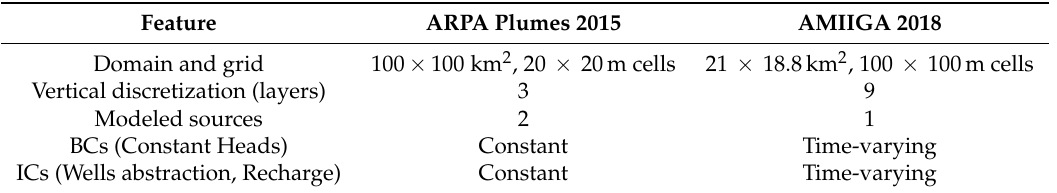
Table 7. Differences between ARPA Plumes 2015 and AMIIGA 2018